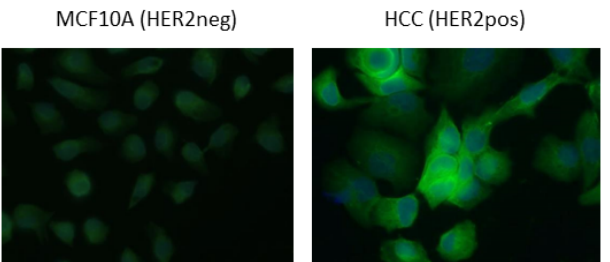
Figure 5. Immunofluorescent staining of HCC (HER2 pos) cells. Direct staining of HER2 neg (MCF10A) and HER2 pos (HCC) cells performed using Alexa488-labeled A10